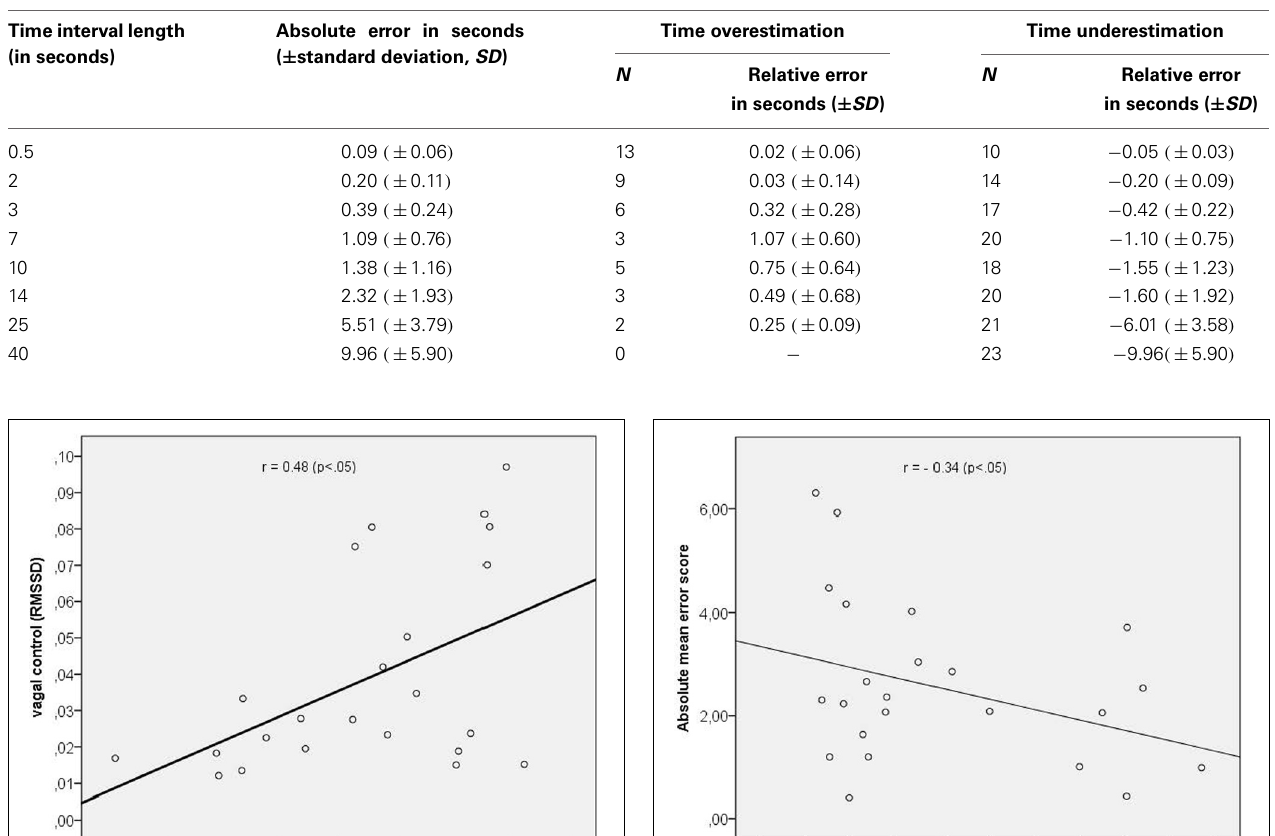
Table 1 | Absolute and relative errors for the different time interval lengths used.